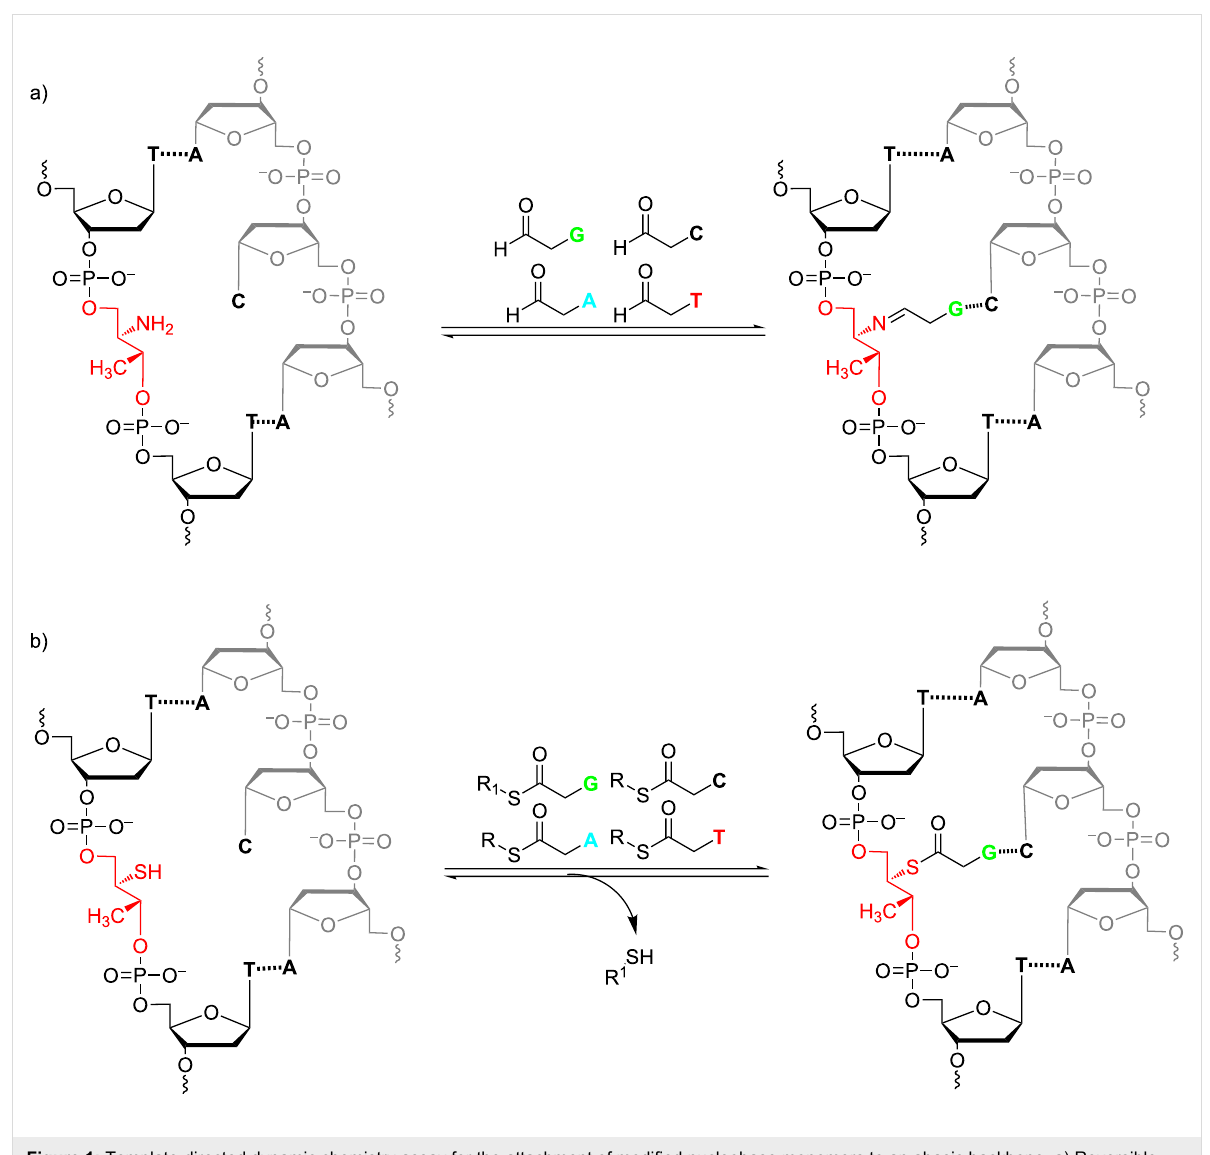
Figure 1: Template-directed dynamic chemistry assay for the attachment of modified nucleobase monomers to an abasic backbone. a) Reversible imine exchange reaction. b) Reversible thioester exchange reaction.